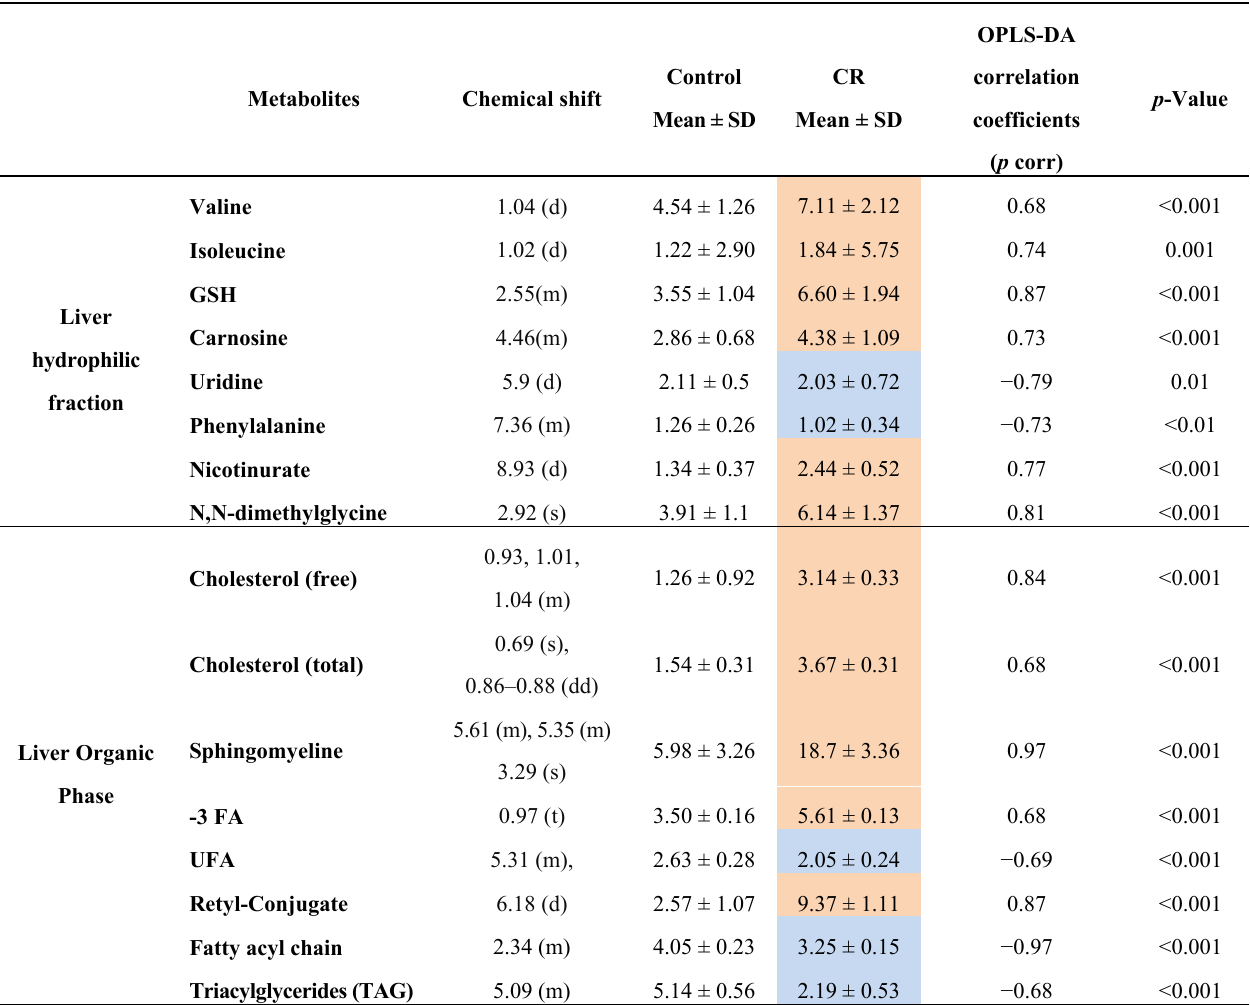
Table 2. Peak integrals (as a.u. = area under) for significantly regulated metabolites in